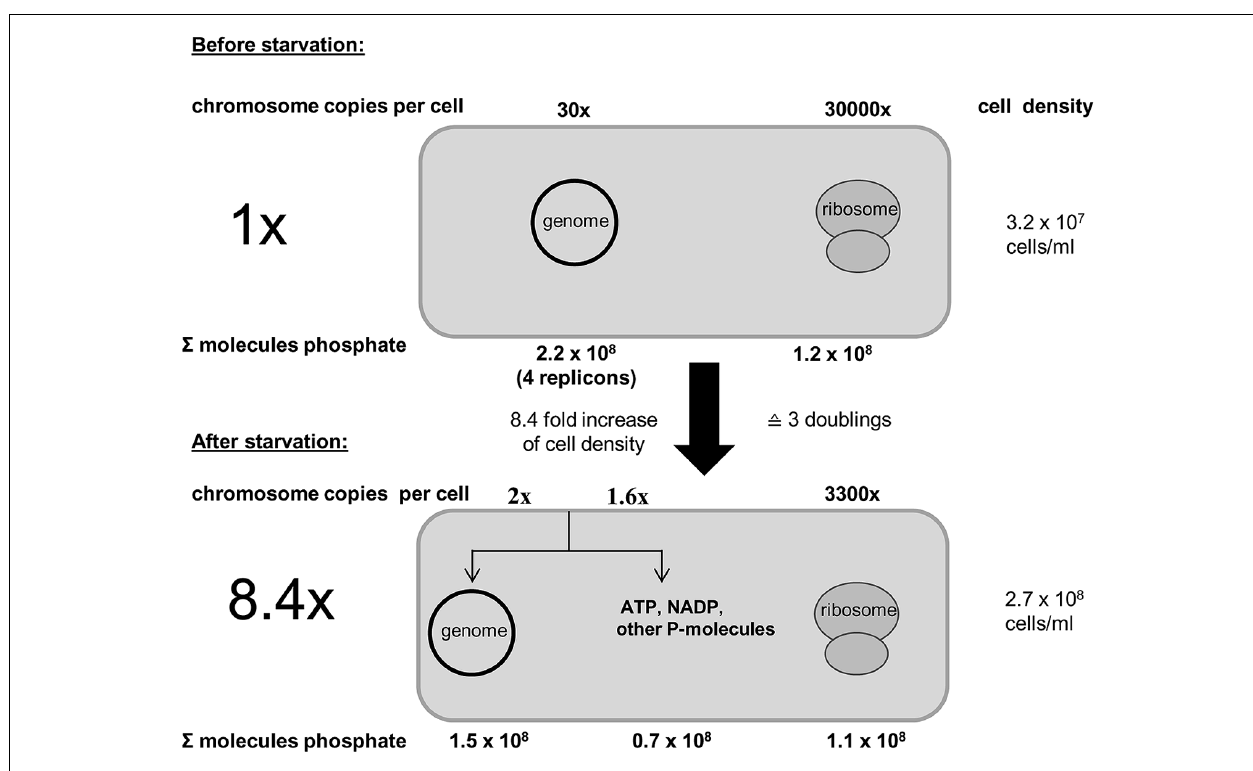
FIGURE 3 | Schematic overview of the phosphate balance of H. volcanii prior to and after growth in the absence of external phosphate. It is taken into account that the cell number increased 8.4-fold during growth in the absence of phosphate.The number of chromosomes and ribosomes were quantified (taken from Zerulla etal., 2014b).